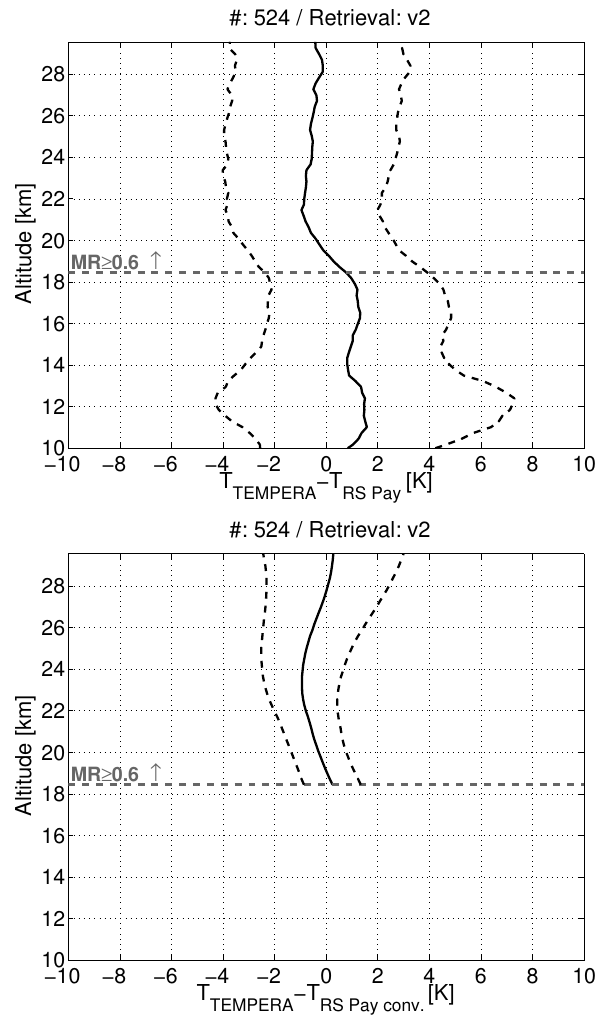
Fig. 17. Comparison of 524 profiles (1 January to 13 Decem- ber 2012) between TEMPERA and radiosonde data from Payerne over an altitude range from 10km to about 29km. Plotted are the mean (black line) and plus and minus one standard deviation around the mean (black dashed line) of the difference between TEM- PERA and radiosonde data from Payerne. The horizontal dark grey line indicates the region where MR=0.6. Upper panel: TEMPERA compared with unconvolved radiosonde data from Payerne. Lower panel: TEMPERA compared with convolved radiosonde data from Payerne over an altitude region with MR ≥ 0.6.